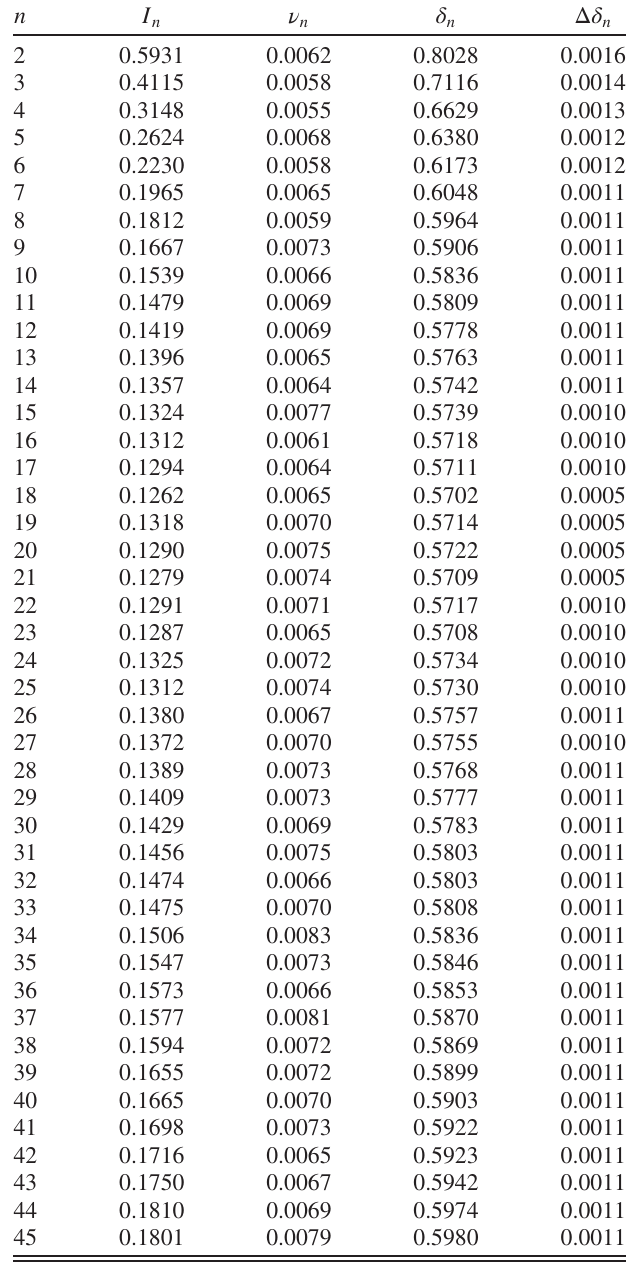
TABLE III. Analyzed data for the chained Bell inequality [Eq. (8)].